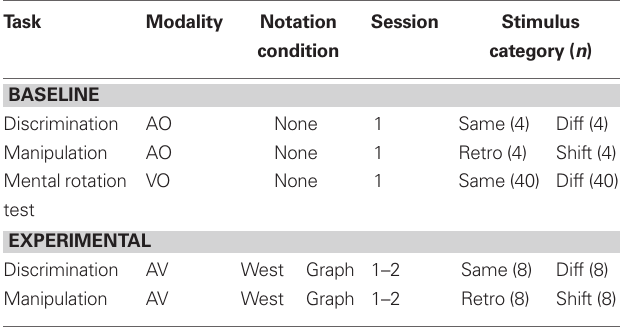
Table 3 | stimuli and conditions for the baseline and experimental rhythmic tasks.